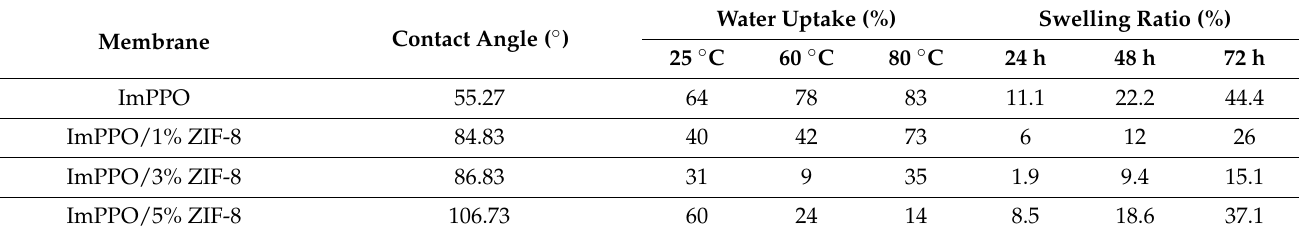
Table 1. Contact angle, water uptake, and membrane swelling ratio of IMPPO/ZIF-8 membrane.